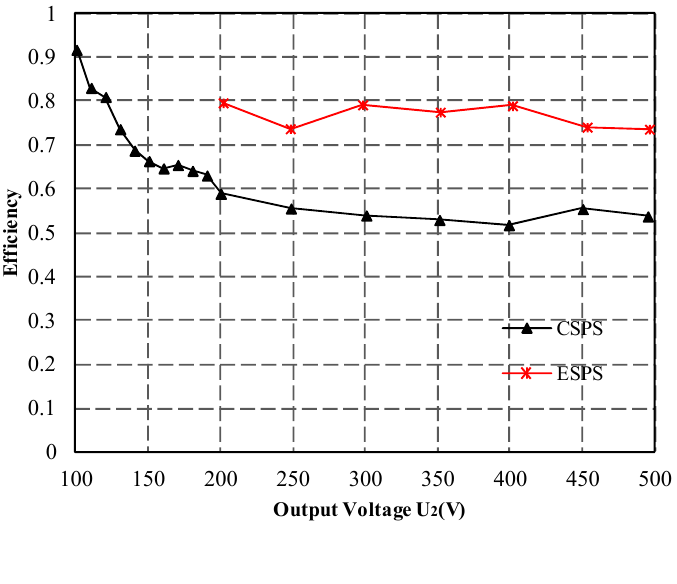
Figure 15. Comparison of system efficiency with CSPS and ESPS control when 2 5 d  